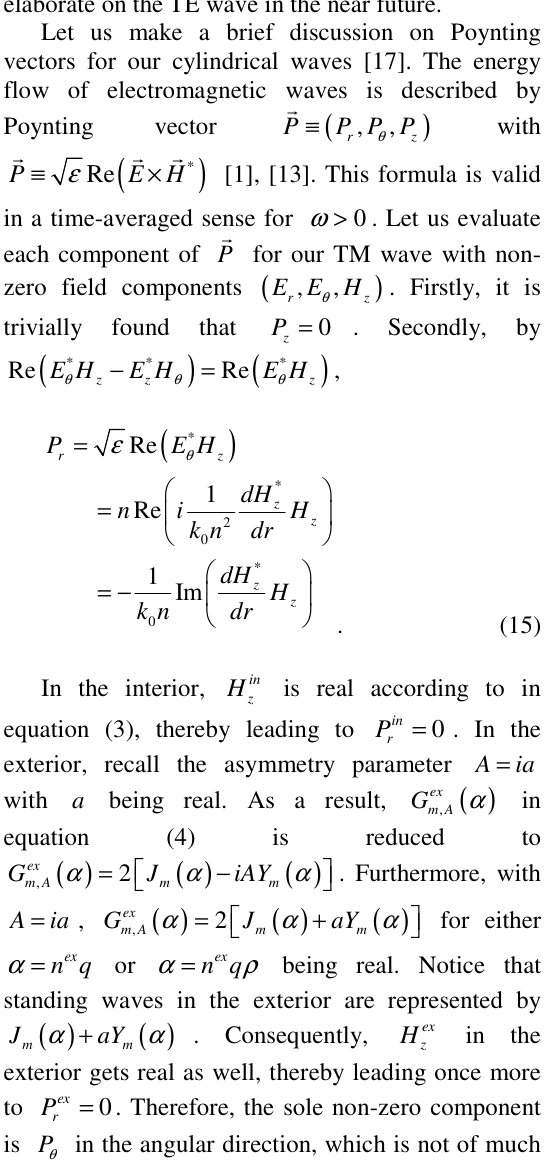
trivially found that 0